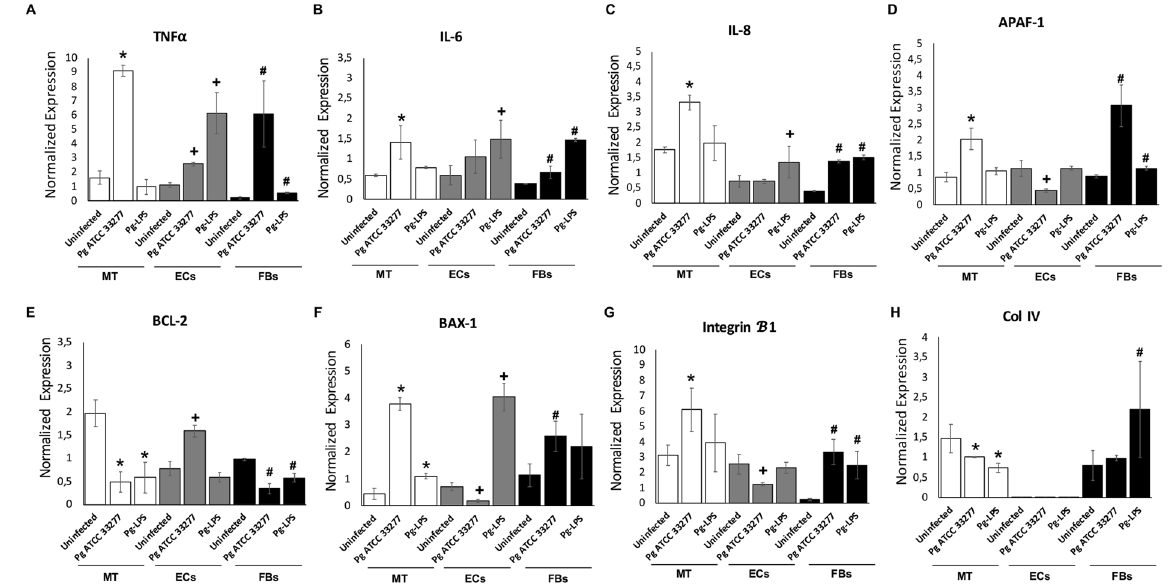
Figure 7. P. gingivalis infection induces an inflammatory and pro-apoptotic cell death response in MT correlated to increased gene expression. ( A – F ) Gene expression of inflammatory and pro-apoptotic cell death response related genes: TNF- α , IL-6, IL-8, Bax-1, Bcl-2 and Apaf-1 in MT; monolayer cell culture of ECs and FBs infected with P. gingivalis at MOI 100 for 24 h; ( G , H ) Gene expression of integrin β 1 and collagen IV. * Differences between infected or stimulated MT vs control ( p < 0.05). + Differences between infected or stimulated ECs vs control ( p < 0.05). # Differences between infected or stimulated FBs vs control ( p < 0.05).